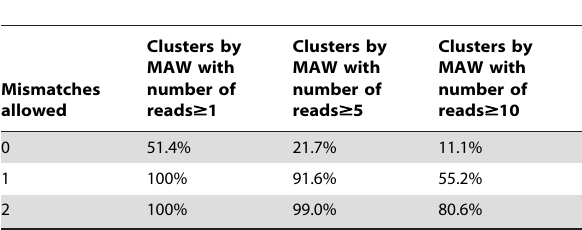
Table 1. Sensitivities of short read clusters for identification of splicing events based on splicing events identified by